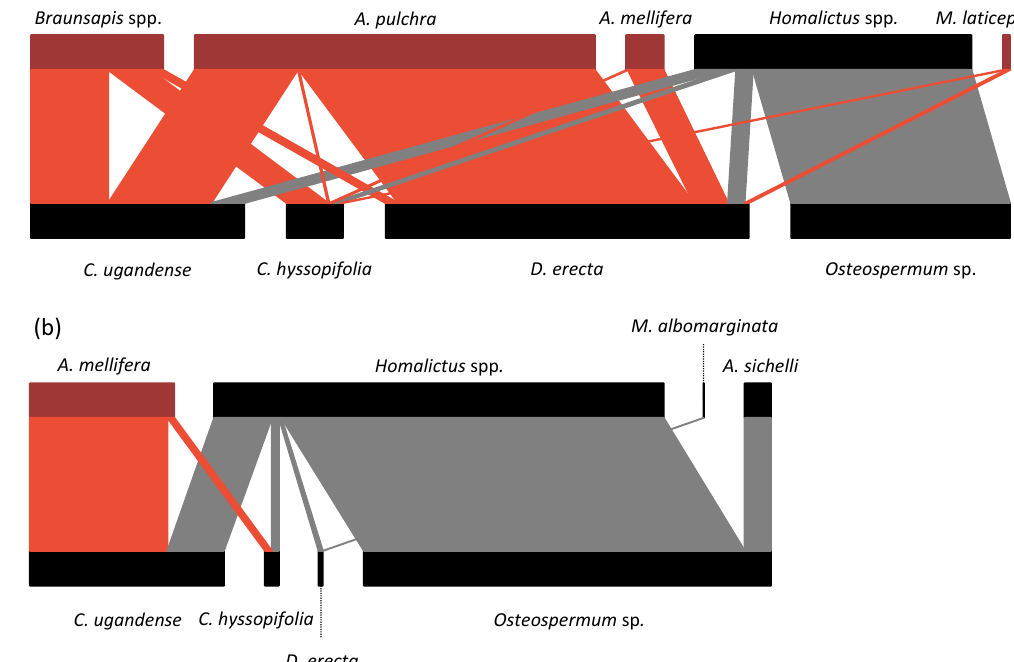
Figure 3. Plant–pollinator networks for ( a ) the urban context and ( b ) the natural context. Higher trophic levels represent bee taxa, and lower trophic levels represent species of the exotic experimental plant communities. The width of the links is proportional to the average number of interactions realized per 1000 flowers between two species. Exotic bee taxa and their interactions are illustrated in red.